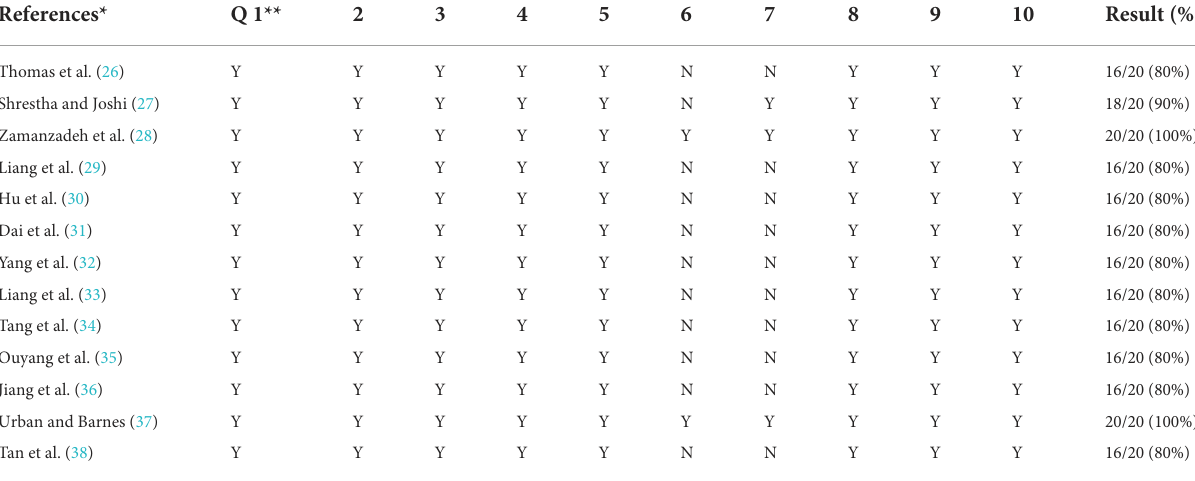
TABLE 1 Quality assessment of included studies in